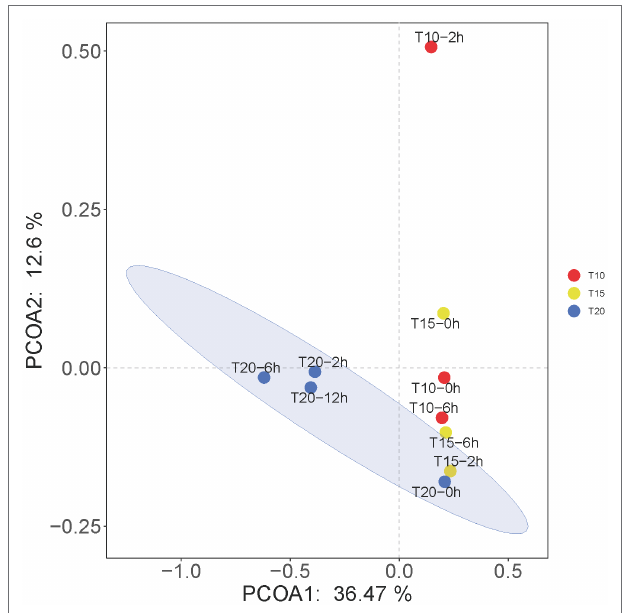
FIGURE 5 | Principal coordinates analysis (PCoA) at the OTU levels of the intestinal microbiome of juvenile O. stewarti . T10, T15, and T20 indicate 10 ° C, 15 ° C, and 20 ° C acclimation temperature backgrounds of the experimental fish; 0–12 h represent the duration of the heat stress.